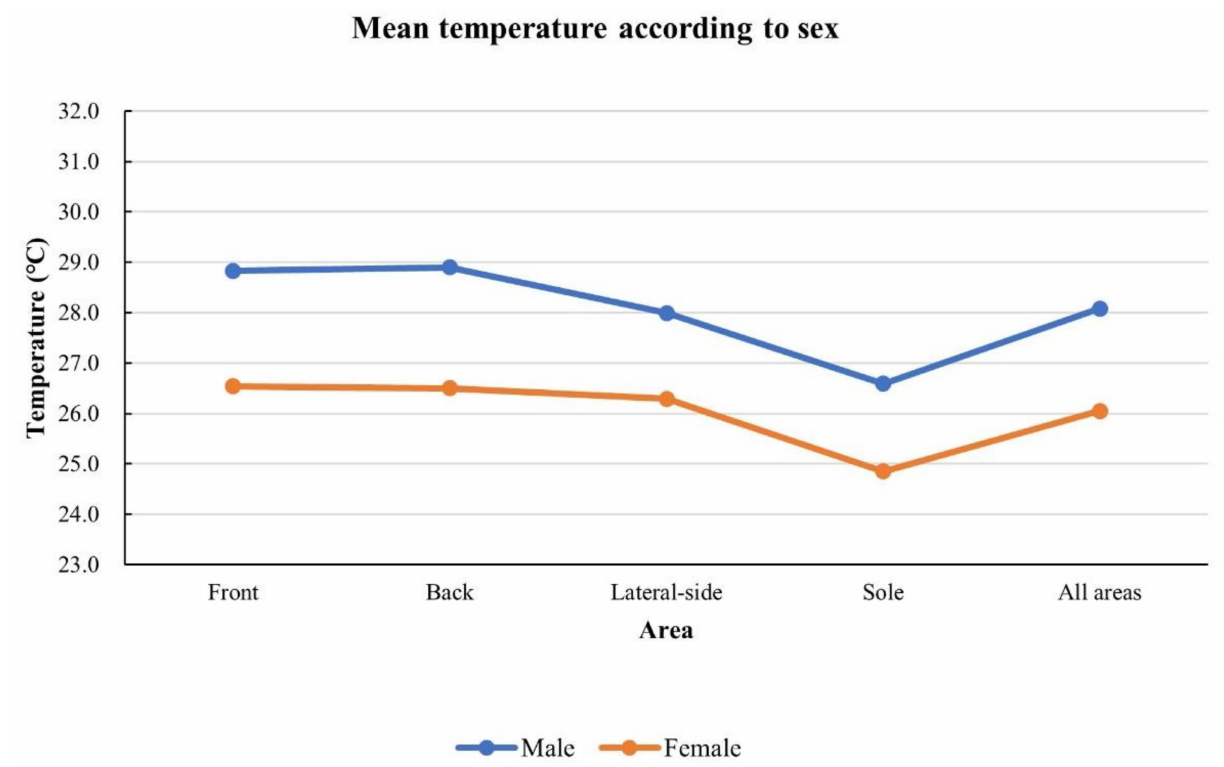
Figure 6. Trend of temperature according to sex in each